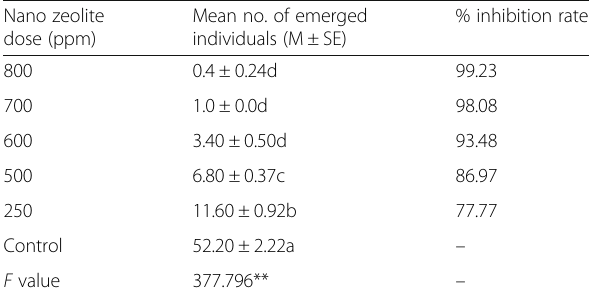
Table 3 Mean number (±SE) of progeny counts and inhibition rate (%) of T. confusum exposed for 14 days to wheat kernels treated with different nano zeolite dose rates Nano zeolite dose (ppm)